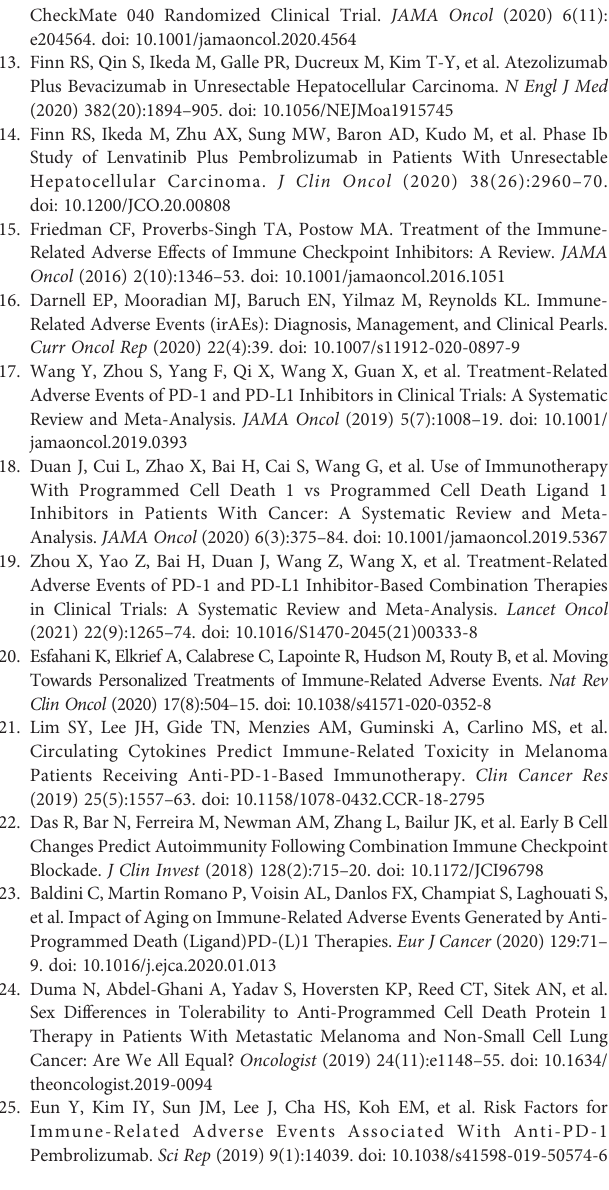
Supplementary Figure 1 | Comparison of CRP, IL-6, and lymphocyte subsets between baseline and the follow-up cut-off point in non-irAEs patients. CRP, C- reactive protein; IL-6, interleukin-6; ns, no statistical difference. Supplementary Figure 2 | Comparison of liver function and blood routine at baseline, irAEs onset, and post-irAEs in patients with irAEs, except hepatitis patients. ALB, albumin; TBIL, total bilirubin; CHE, cholinesterase; LDH, lactate dehydrogenase; PTA, prothrombin activity; WBC, white blood cell; ANC, absolute neutrophil count; AMC, absolute monocyte count; LYM, absolute lymphocytes; PLT, platelets; NLR, neutrophil-lymphocyte ratio; PWR, platelet-white blood cell Supplementary Table 1 | The occurrence of adverse events at patient admission to the hospital. Supplementary Table 2 | Comparison of laboratory results between baseline and the follow-up cut-off in patients without irAEs. ALB, albumin; TBIL, total